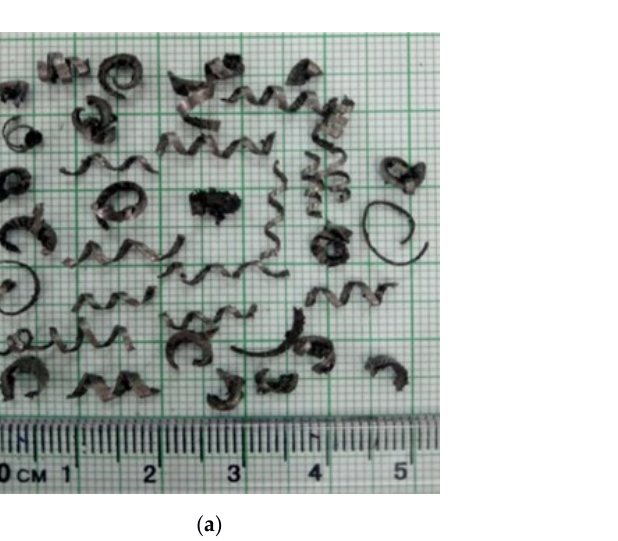
Figure 1. Size specification of Fe 0 materials tested—( a ) Scrap iron ( b ) Steel wool. Table 1. Elemental composition of tested Fe 0 materials. LOD stands for the lowest concentration at which an element can be detected